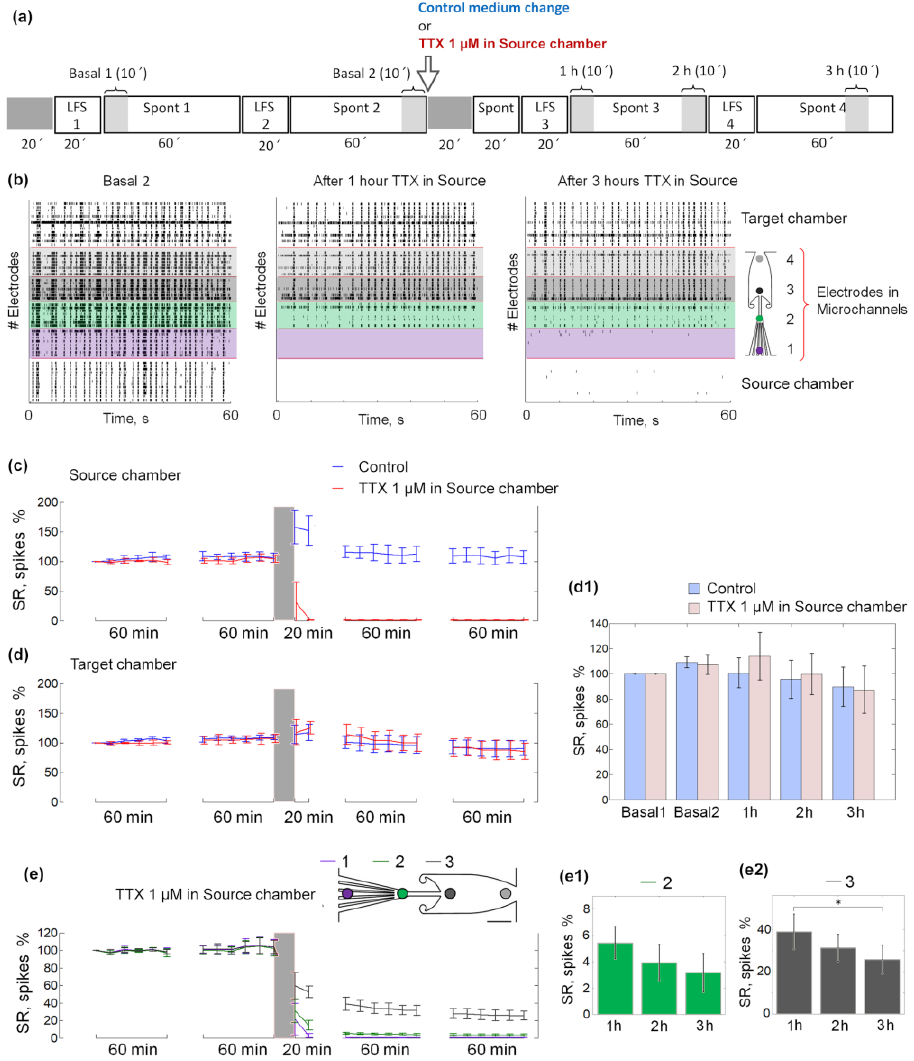
Figure 2. Network activity with 1 µ M TTX application in the Source chamber. ( a ) The experimental protocol consisted of spontaneous activity recording (Spont) and low-frequency stimulation (LFS) series. The arrow indicates the application of TTX to the Source chamber or the change of medium in control experiments. ( b ) An example of raster plots showing 60 s of spontaneous activity in basal conditions ( left ), 1 h ( middle ), and 3 h ( right ) after TTX application in the Source chamber. Each dot represents a spike, each row an electrode. The electrodes are highlighted in color according to the scheme on the right. ( c , d ) Spiking rate (SR) of spontaneous network activity normalized to the SR in the first 10 min of the recording. Each dot represents SR (Mean ± s.d.) during 10 min for the neuronal network in the Source chamber (C) and the neuronal network in Target chamber ( d ). The red line corresponds to the activity of cultures with 1 µ M TTX in the Source chamber, blue line corresponds to the activity of control cultures. The gray-shaded area indicates a 15–20 min recording stop during and after manipulation with culture medium and TTX treatment. ( d1 ) Diagram of SR at the first (Basal 1) and the last (Basal 2) 10 min time intervals of basal activity recording, and 1, 2, and 3 h after manipulation with culture medium and TTX application (1–3 h, respectively) in control experiments (blue), and with 1 µ M TTX in the Source chamber (red). ( e ) SR of spontaneous network activity normalized to the SR in the first 10 min of the recording. Each dot represents SR during the 10 min for the neuronal network in electrodes nearest to the Source chamber (marked as 1, purple line), electrodes in the narrow section of microchannels (marked as 2, green line), and electrodes in the wide section of microchannels (marked as 3, gray line) of each culture with 1 µ M TTX in the